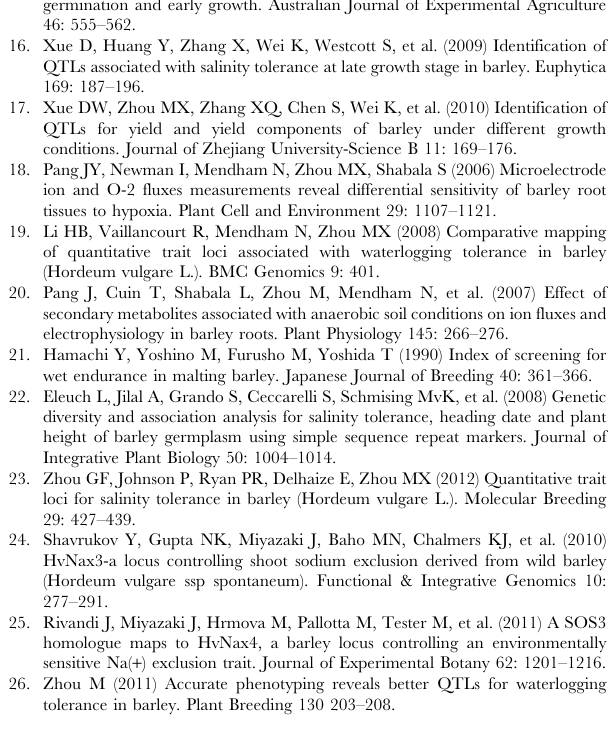
Table S1 Candidate genes in Brachypodium and rice genomes syntenic to salinity tolerance QTL on barley chromosome